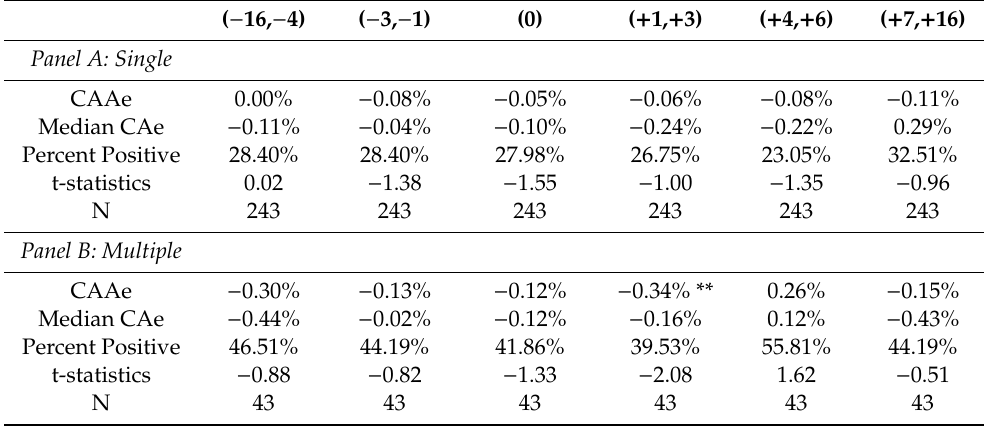
Table 4. The e ff ect of gas discoveries on the real exchange rate for single and multiple